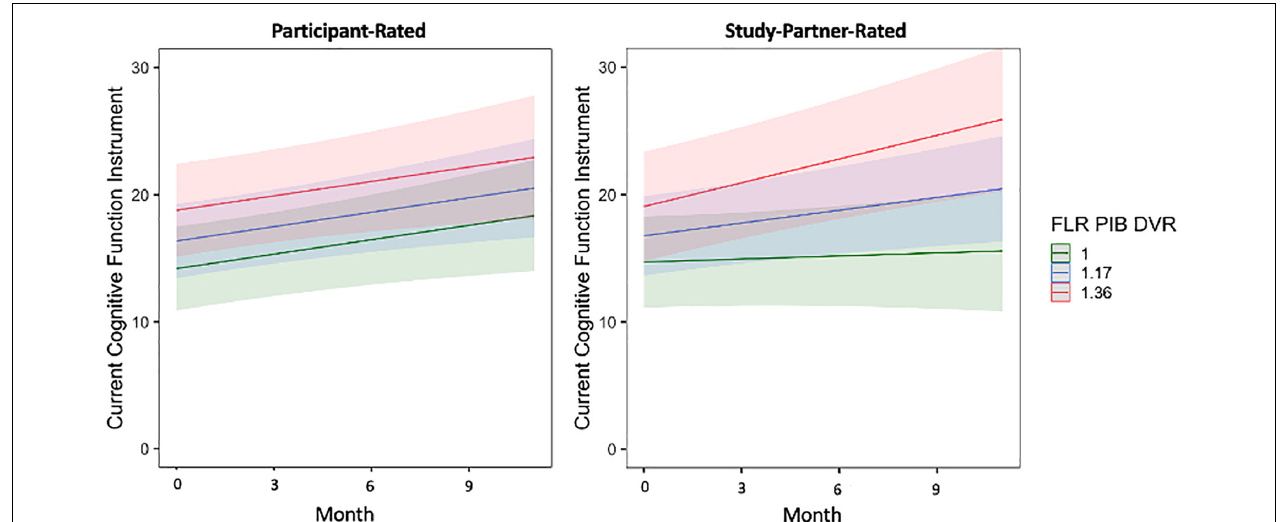
FIGURE 6 | The interaction between baseline participant cerebral amyloid burden (FLR DVR) and time to predict participant-rated (left) and study partner-rated (right) cognitive concerns using the current CFI over only the first year of data collection (first four remote sessions). A significant interaction was seen between amyloid and time when predicting study partner-rated cognitive concerns (fixed estimate = 7.13, adj. p = 0.0330), in that study partner concerns increased over time in participants with higher amyloid burden at baseline. The interaction between amyloid and time predicting participant-rated cognitive concerns over the first year of data collection was not significant (fixed estimate = 0.20, adj. p =